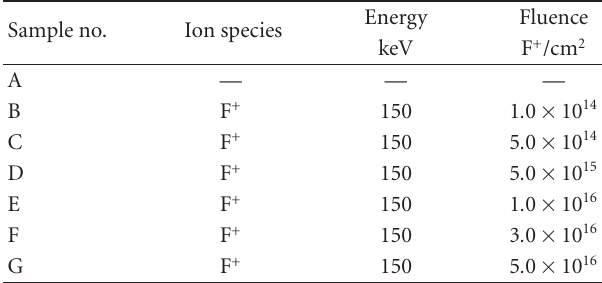
Table 1: The nomenclature of the unimplanted and implanted